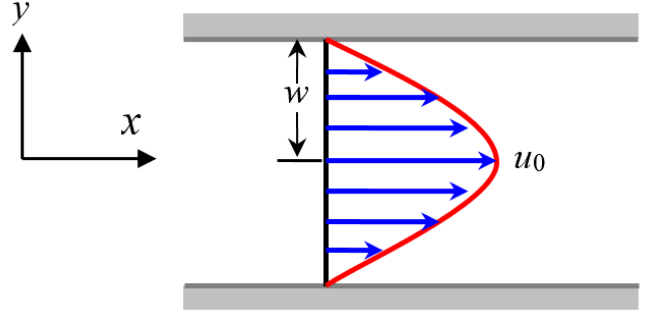
Figure A1. Schematic diagram of the steady-state plane Poiseuille flow.